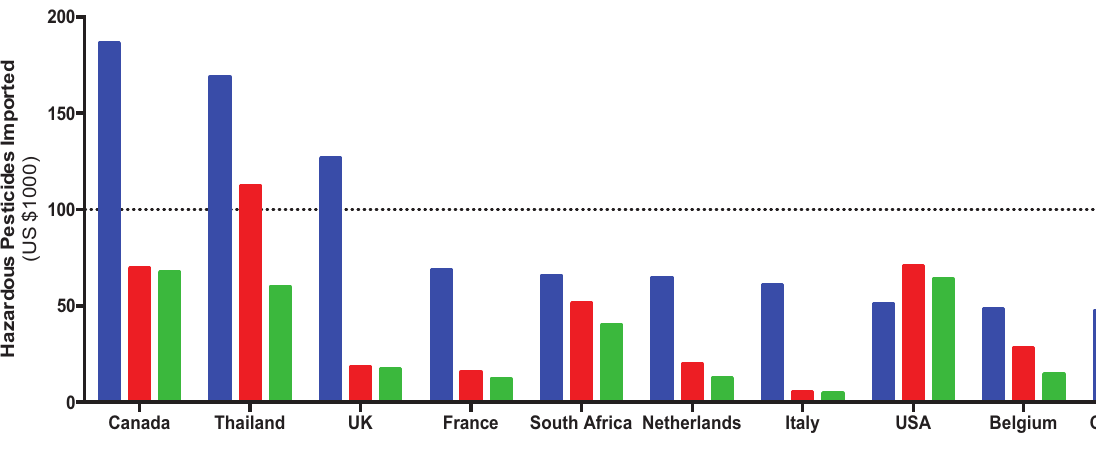
Figure 5. Expenditures for the top ten pesticide-importing countries (2007 –